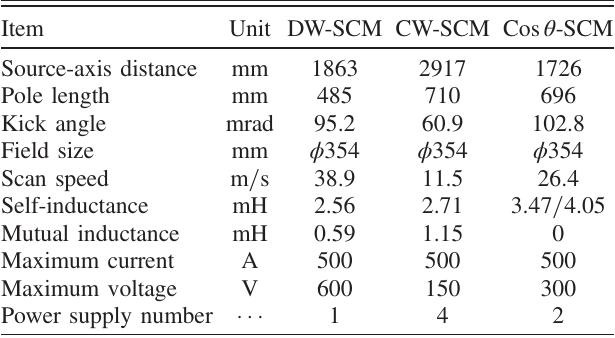
TABLE II. Magnet arrangements for proton therapy system.